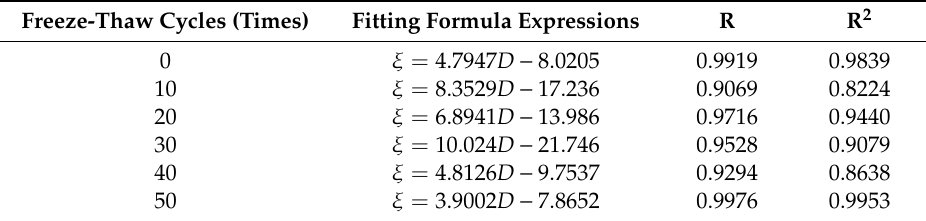
Table 7. Fitting formula expressions and correlation coe ffi